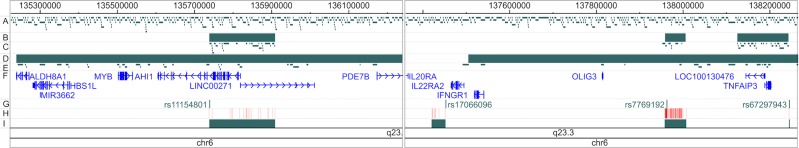
Overview of MS 6q23 Immunochip associated regions.Tracks are labelled as follows: A–HindIII restriction fragments; B–LD regions targeted in ‘region’ Capture Hi-C; C–HindIII restriction fragments targeted in ‘region’ Capture Hi-C; D–Gene regions targeted in ‘promoter’ Capture Hi-C; E–HindIII restriction fragments targeted in ‘promoter’ Capture Hi-C; F–RefSeq genes (packed for clarity); G–MS index SNPs; H–Density of MS LD SNPs (r2 ≥ 0.8) and I–MS LD regions. The genomic region chr6:136,238,000–137,360,000 has been omitted for clarity. All co-ordinates are based on GRCh37. Generated using the WashU EpiGenome Browser (http://epigenomegateway.wustl.edu/browser/).